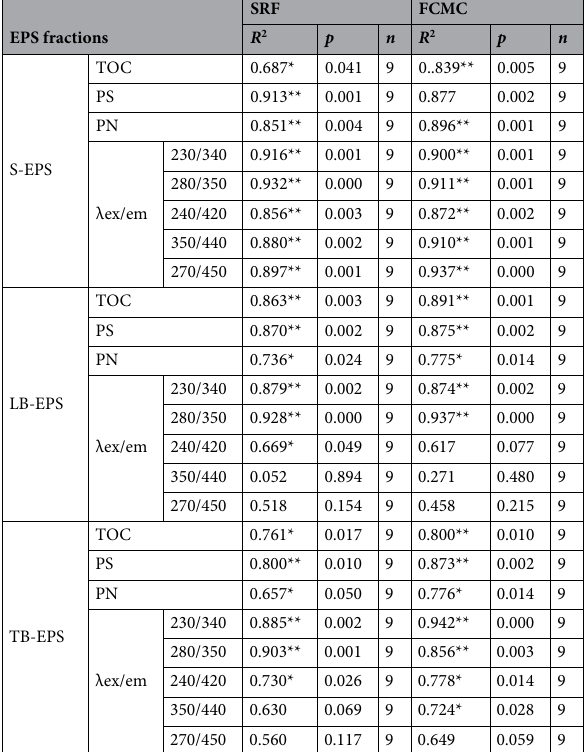
Table 3. Pearson correlation between the sludge dewaterability and the PN, PS and TOC contents or the intensities of various 3D fluorescent signals in different EPS fractions. *Correlation is significant at the 0.05 level (2-tailed). **Correlation is significant at the 0.01 level